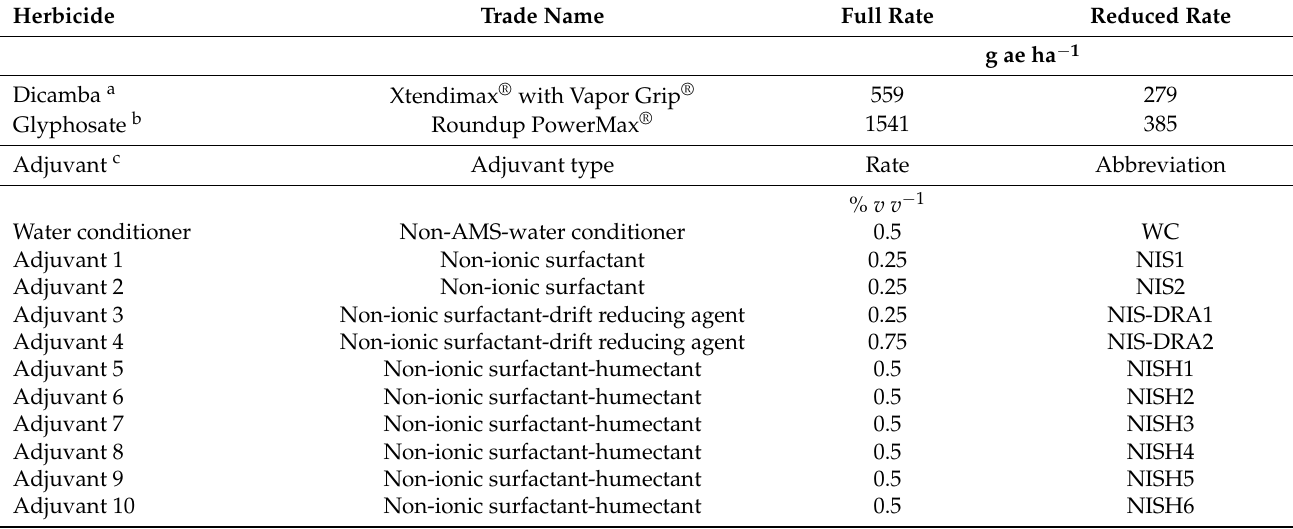
Table 1. Description of the herbicides and adjuvants